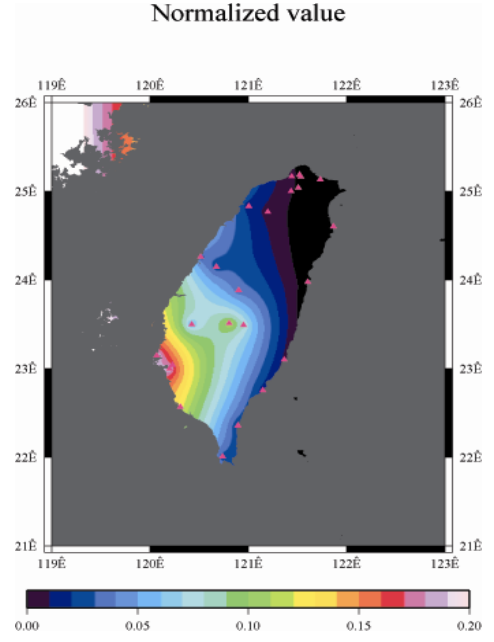
Figure 24. Normalized values of rainfall when the plum rains gradually moved north (June 3rd, 2008, 12:00 AM).